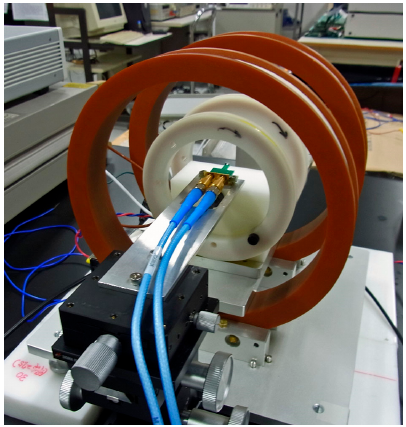
Figure 11. Photograph of dual-Helmholtz coil equipment used in sensitivity evaluation.